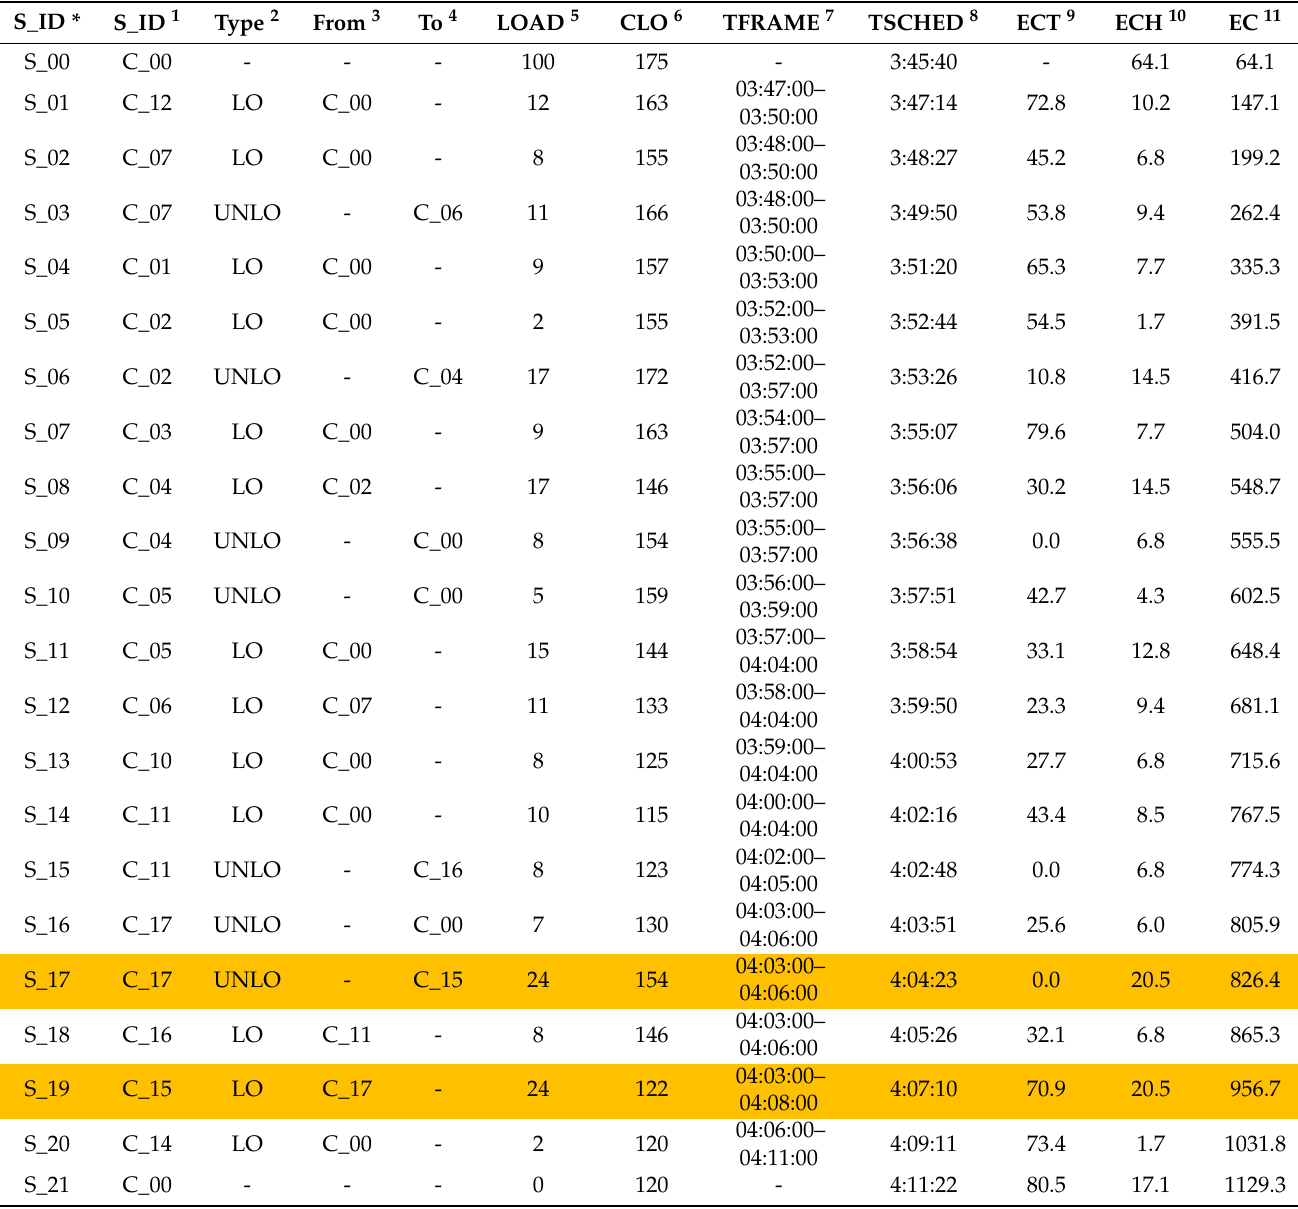
Table 10. Numerical results of the scheduling of predefined and real-time-generated specific in-plant material supply operations performed by the milk-run trolley within route 2. The colored rows represent the real-time added supply demands generated by the supervisory level using the results of the optimization based on the digital twin